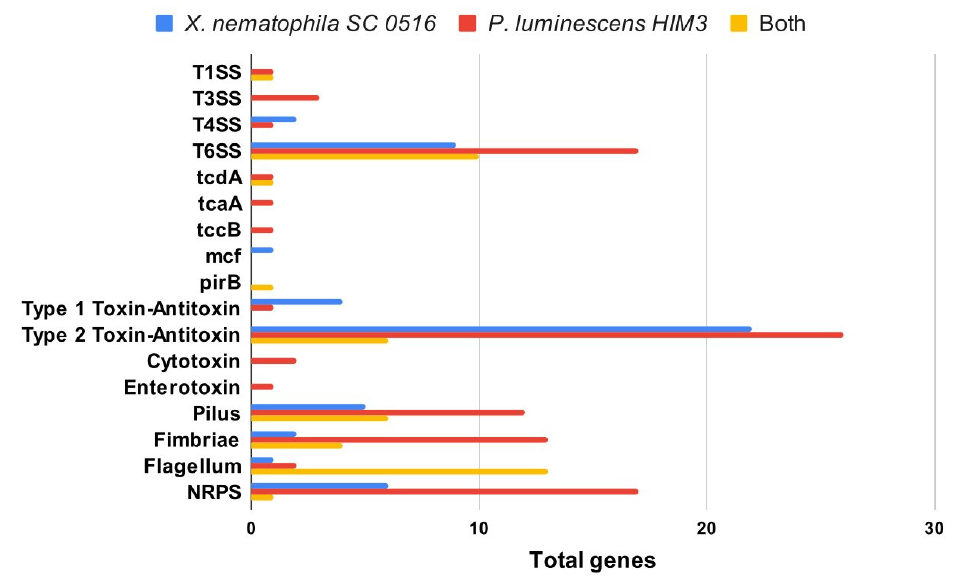
Figure 5. Unique and shared genes between X. nematophila SC 0516 and P. luminescens HIM3. The x-axis indicates the total number of genes present in one or both bacteria, and the y-axis indicates the types of genes associated with virulence; Type Secretion System (TSS), Toxin Complex (tc), Makes Caterpillars Floppy (mcf), Photorhabdus Insect-Related Toxins (Pir), and Non-Ribosomal Peptide Synthetases